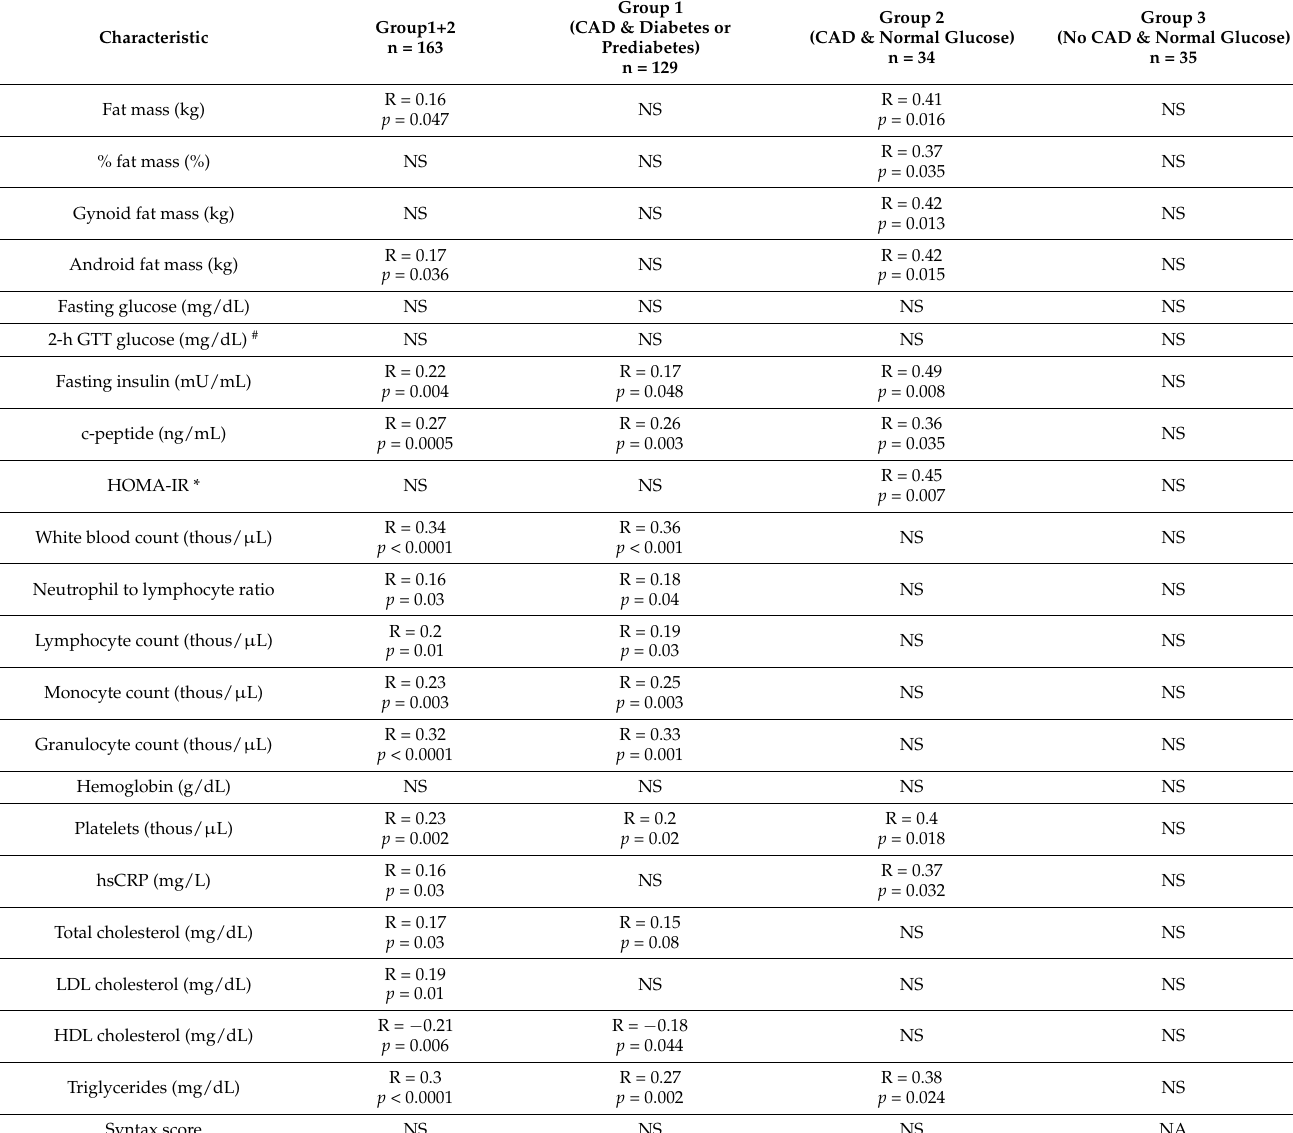
Table 3. Spearman rank order correlations for